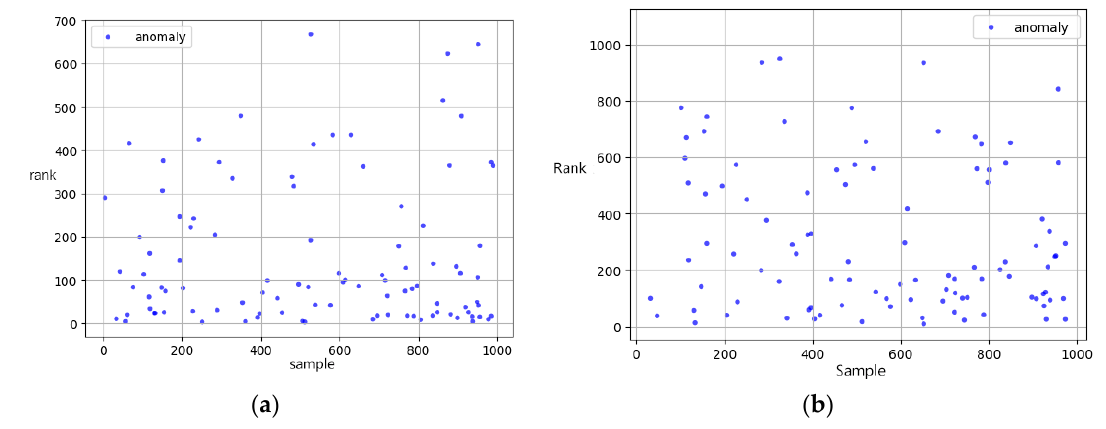
Figure 5. Ranks of known abnormal record based on ( a ) our model ( b ) traditional rule.